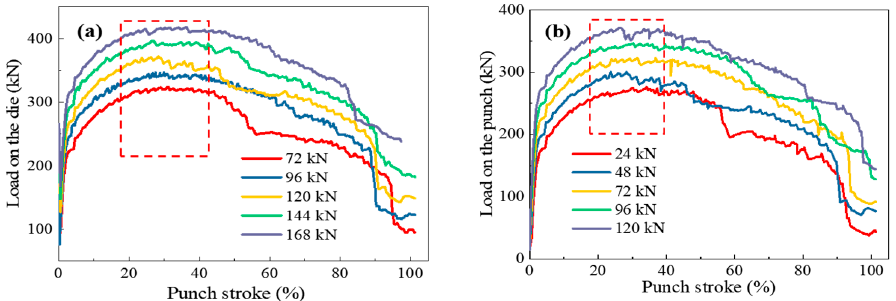
Figure 4. Influence of forming force changes on die load: ( a ) changes of die load when blank holder force is changed; ( b ) changes of die load when counter punch force is changed.